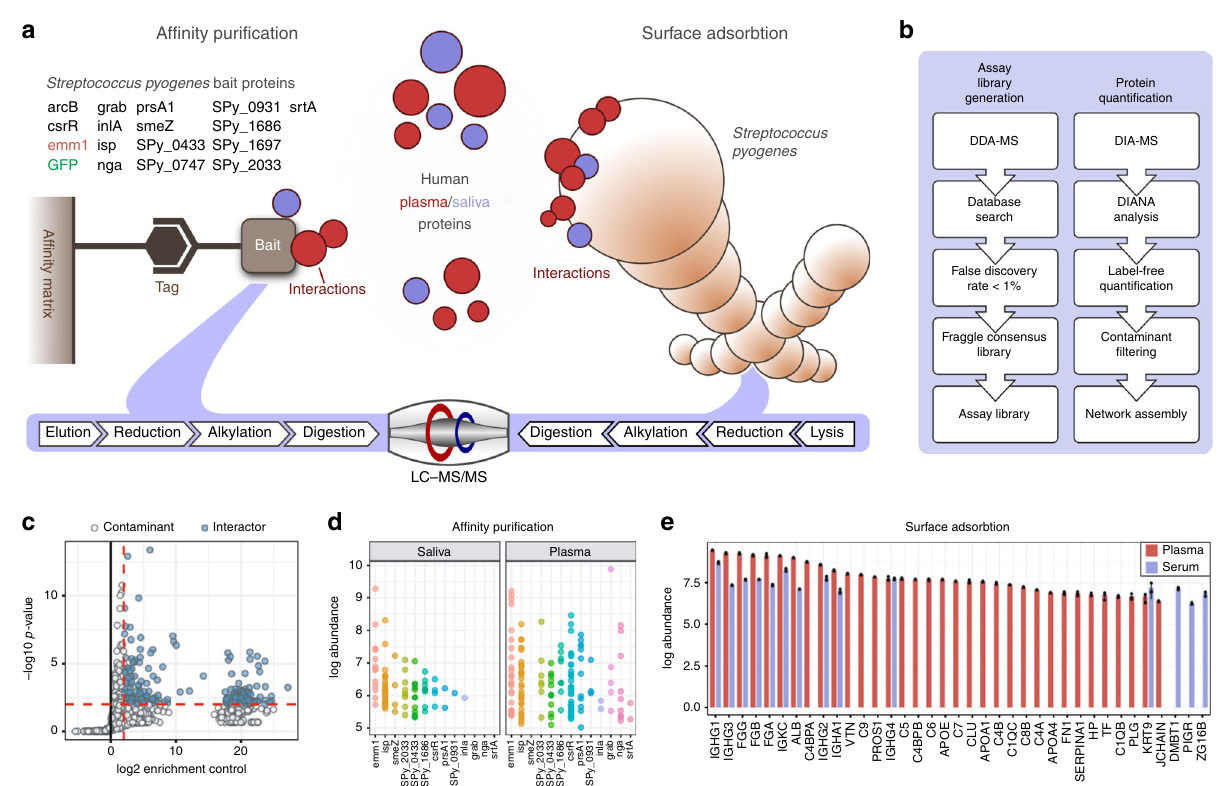
Fig. 1 Construction of the combined AP – DIA and SA – DIA interaction maps. a The af fi nity tagged streptococcal bait proteins used in the AP – DIA approach are indicated in black with their respective gene names, the M1 protein ( emm1 ) is highlighted in red, and sfGFP used as a negative control is shown in green. Eight of the proteins included in this study are uncharacterized (Supplementary Data 1); albeit some of them have homologs in other species. Additionally, we included seven characterized or partly characterized proteins (Supplementary Data 1). Throughout this paper all proteins are referred to by their gene names, as the majority of the streptococcal proteins included in this study are uncharacterized proteins without de fi ned protein names. All proteins were expressed as recombinant proteins, attached to an af fi nity-matrix via an af fi nity-tag, and interacting proteins from plasma and saliva were captured, prior to sample elution and reduction, alkylation and trypsin-digestion for mass spectrometry (MS) analysis. In the SA – DIA approach, intact bacteria were used as an af fi nity platform to capture human plasma and saliva proteins, prior to cell lysis and reduction, alkylation, and trypsin-digestion. b The samples from the AP – DIA and SA – DIA approaches were analyzed via data-dependent acquisition-MS (DDA-MS) at a false discovery rate (FDR) of <1%. Fraggle 60 was used to construct an assay library used for label-free quanti fi cation of identi fi ed peptides via DIA-MS using the DIANA software 61 , with subsequent contaminant fi ltering of AP – DIA data and network assembly. c These AP – DIA interactions were strongly fi ltered to include only high-con fi dence interactions (blue dots) that were identi fi ed with three proteotypic peptides, which were >4-fold enriched and had an adjusted P- value < 0.01 compared to proteins enriched using sfGFP using the Student ’ s t -test 6 in n = 3 biologically independent samples. White dots indicate contaminating proteins falling below the set thresholds. d Intensity distribution of the 226 interacting proteins per bait in the AP – DIA approach. Each dot represents the intensity value for an interacting protein, and colors indicate the respective S. pyogenes bait protein. e Human plasma and saliva proteins identi fi ed as associated with the streptococcal surface in the SA – DIA approach. Error bars are expressed as standard deviation (s.d.) from the mean. Source data are provided as a Source Data